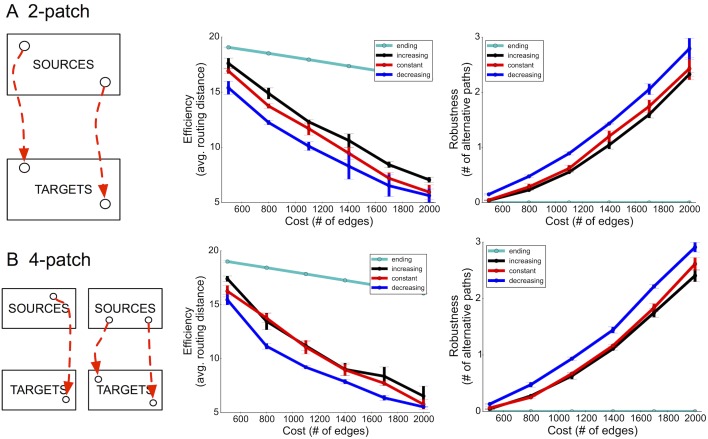
Similar advantages of decreasing pruning rates are observed when using a network-flow-based model of network activity.A) 2-patch input distribution and B) 4-patch input distribution.